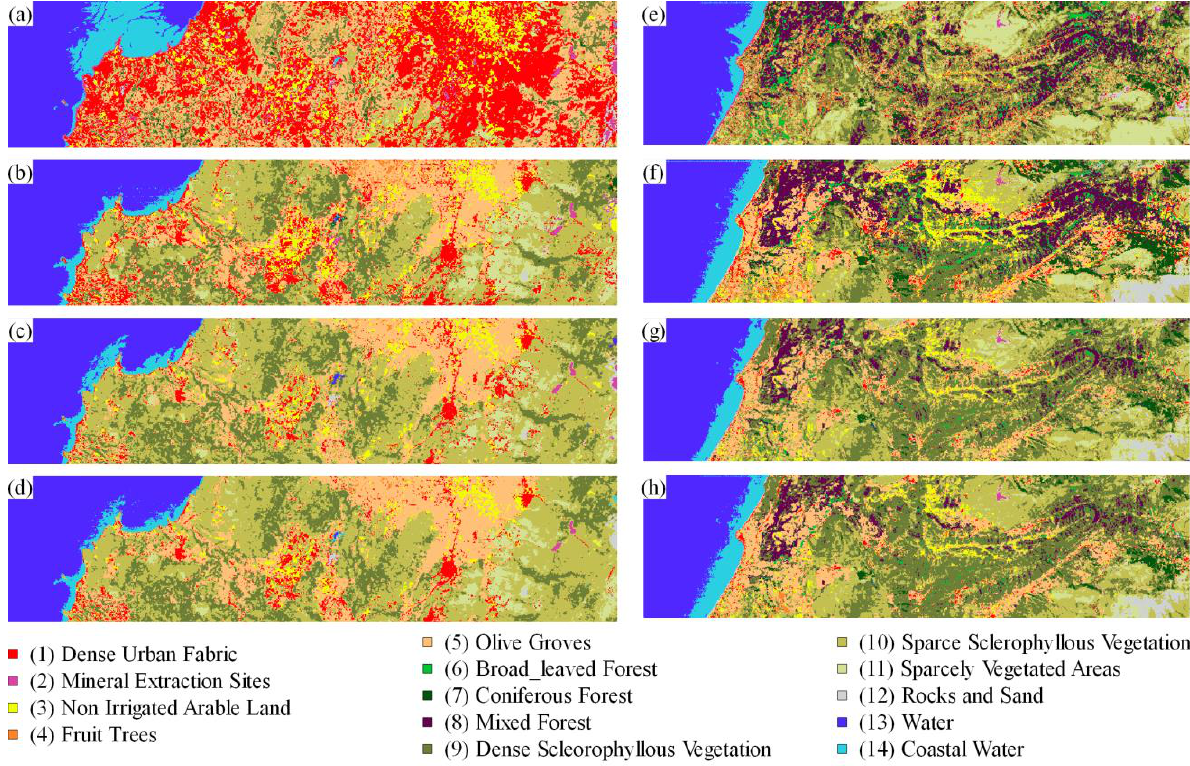
Figure 2. LULC classification for Dioni image through (a) SAM (b) SVM (c) RF bands (d) RF pca – LULC classification for Loukia image through (e) SAM (f) SVM (g) RF bands (h) RF